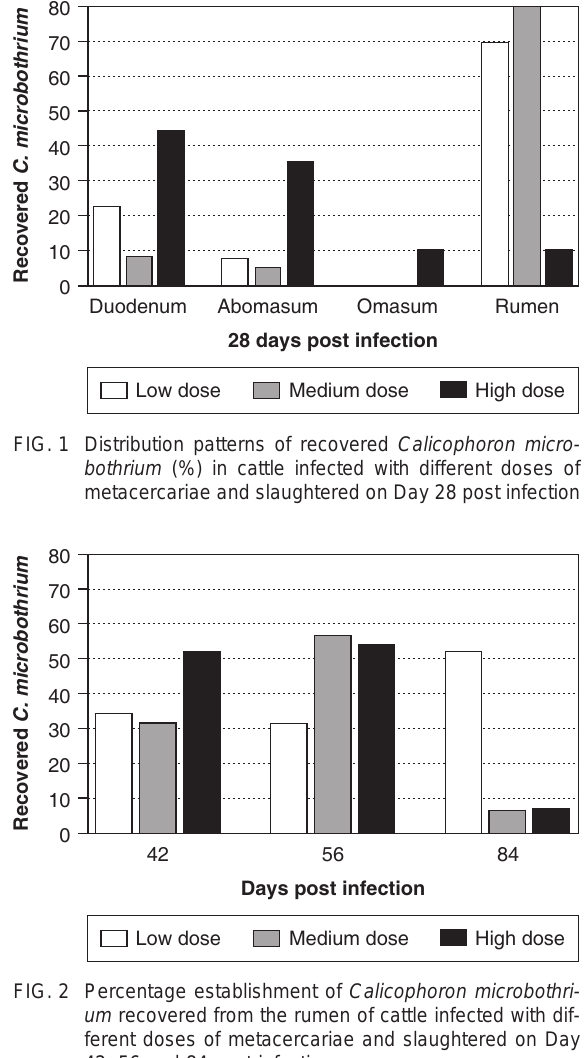
FIG. 2 Percentage establishment of Calicophoron microbothri- um recovered from the rumen of cattle infected with dif- ferent doses of metacercariae and slaughtered on Day 42, 56 and 84 post